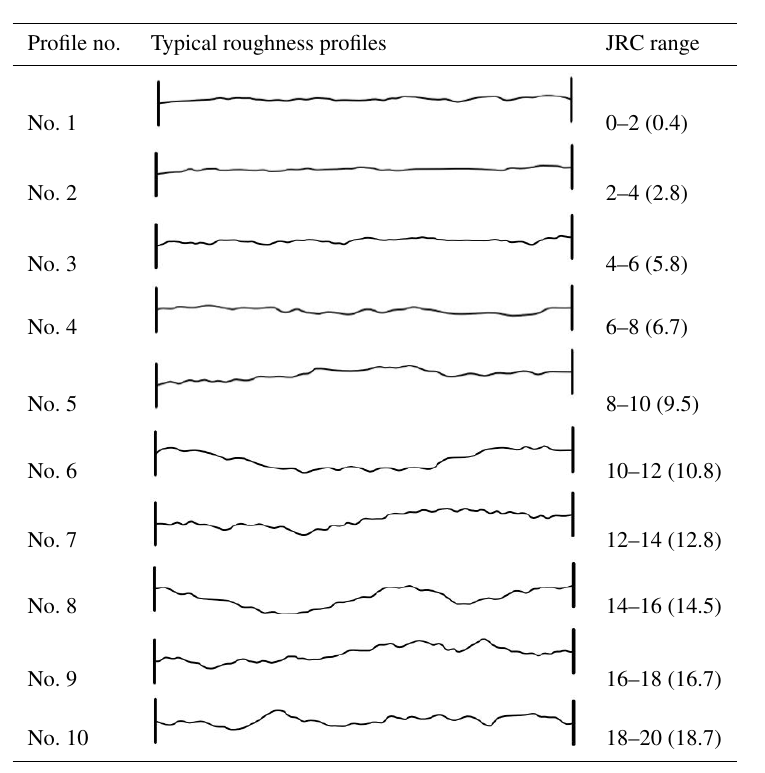
Figure 4. Shear experiment procedure and equipment. Table 2. Ten standard joint profiles (Barton and Choubey,